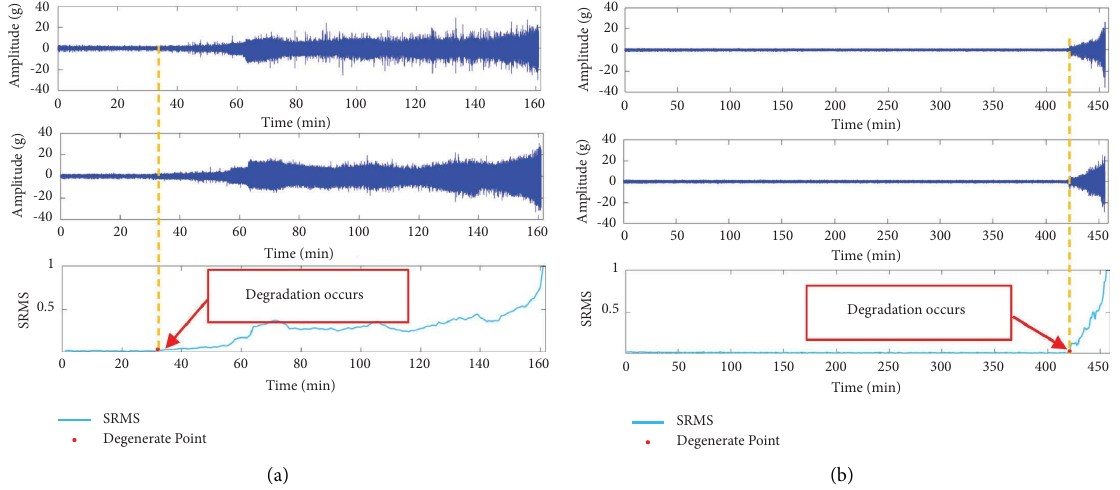
Figure 1: Te evaluation of various bearing initial degradation points. (a) Bearing 1-2. (b) Bearing 2-1.